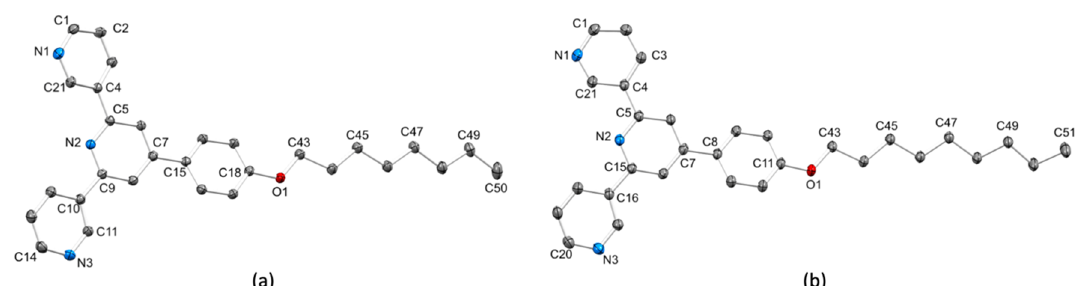
Figure 3. ORTEP representations of one of the two independent molecules of ( a ) 8 and ( b ) 9 (ellipsoids are plotted at a 40% probability level, and H atoms are omitted for clarity). For 8 : C18–O1 = 1.3633(13) Å, C43–O1 = 1.4349(13) Å, C18–O1–C43 = 119.23(8)° and for the second independent molecule, the corresponding values are 1.3630(13) Å, 1.4334(13) Å, and 119.49(8)°. For 9 : C11–O1 = 1.364(3) Å, C43–O1 = 1.437(3) Å, C11–O1–C43 = 118.3(2)° and for the second independent molecule, the corresponding values are 1.365(3) Å, 1.437(3) Å, and 118.22(19)°.